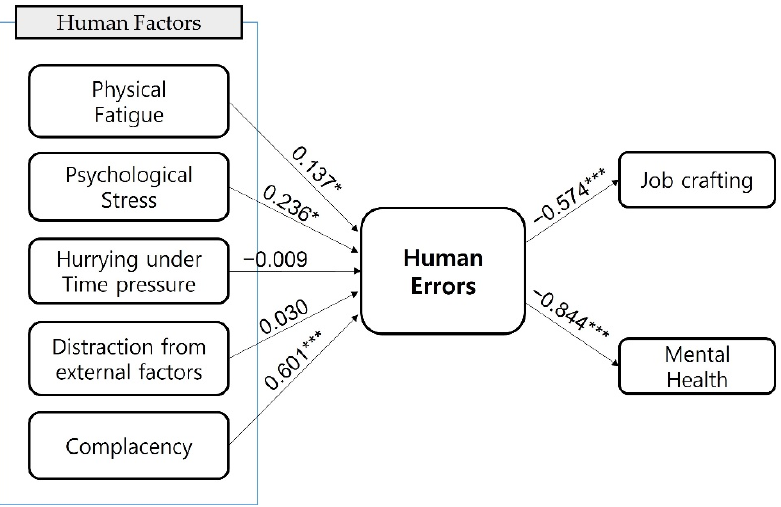
Figure 4. Structural equation model analysis. * p < 0.05, *** p < 0.001.